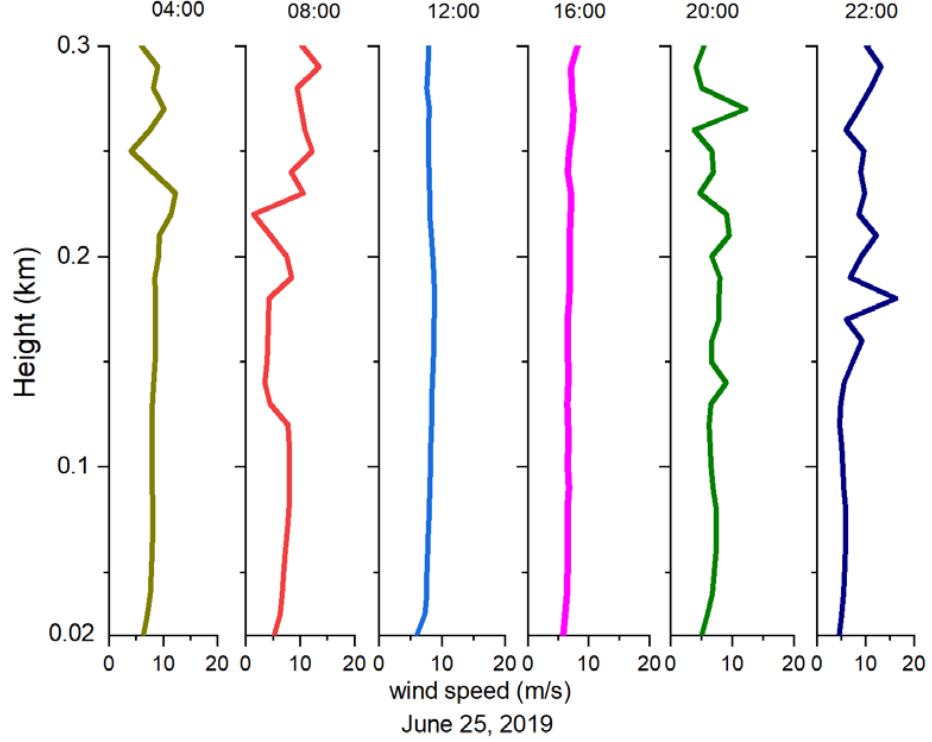
Figure 9. Wind speed profiles measured from sodar on 25 June 2019.